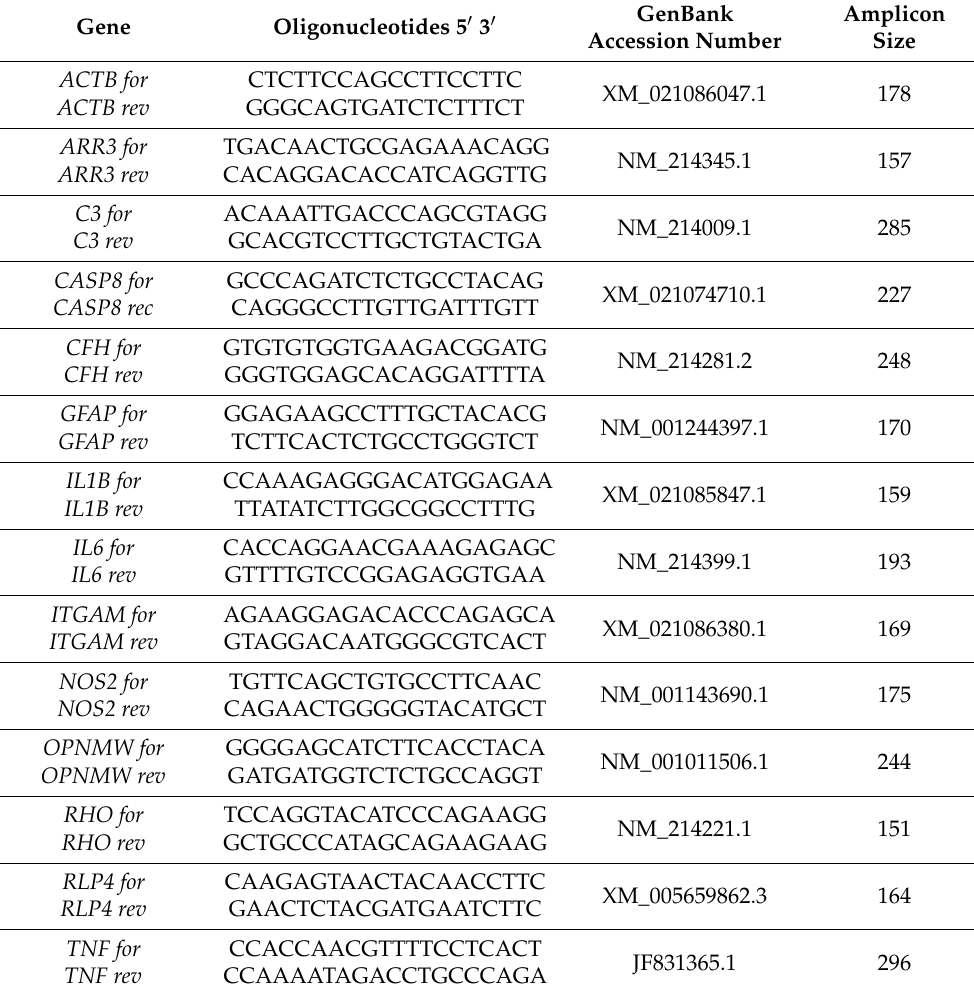
Table 2. List of used RT-qPCR primers.